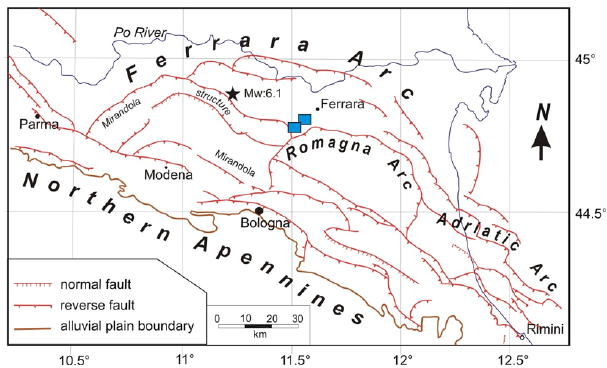
Fig. 1. Simplified tectonic map of the buried northern Apennines showing the studied area (blue boxes SW of Ferrara. Modified from CNR-PFG, 1991).